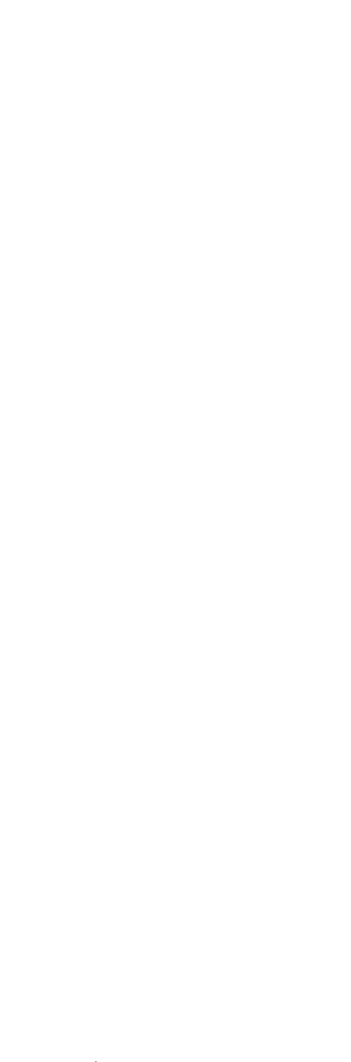
FIGURE 6 | ROC curve of the PTMC ASOS model and the cutoff value. The cutoff value of our PTMC ASOS model was observed by the ROC curve. The cutoff value was 0.0133, with sensitivity of 69.2% and speci fi city of 72.7%. A risk larger than 0.013 could be considered as high risk of large-number LNM, while a risk lower than 0.013 could be considered as low risk of large-number